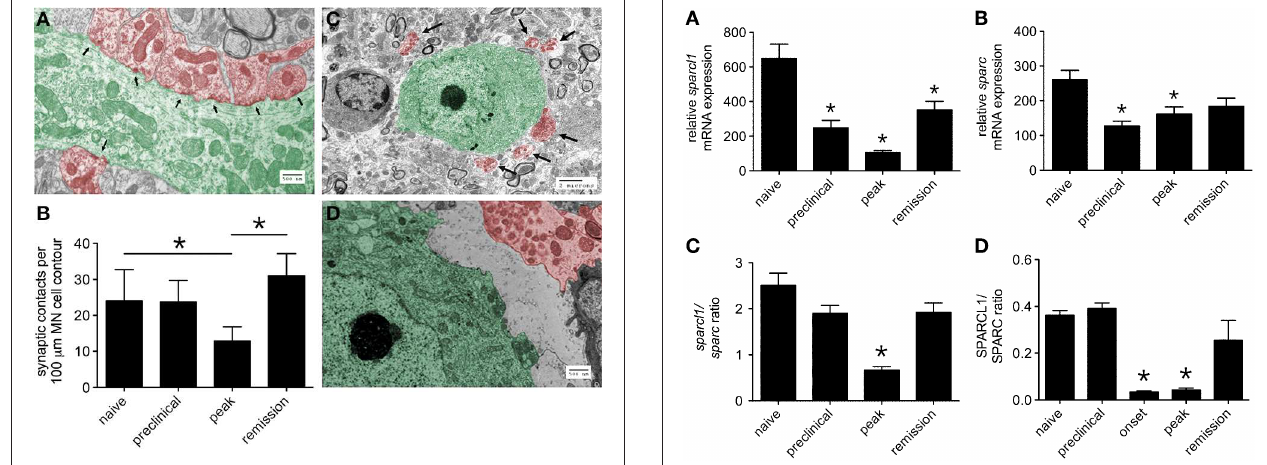
FIGURE 4 | Expression of both sparcl1 and sparc transcripts and SPARCL1 and SPARC proteins changes in lumbar spinal cord tissue over the course of relapsing EAE in SJL mice. (A) Relative sparcl1 mRNA expression fluxes over the course of relapsing EAE ( n = 5 mice per disease stage). (B) Relative sparc mRNA expression also changes over the course of relapsing EAE ( n = 5 mice per disease stage). (C) The calculated sparcl1 to sparc mRNA expression ratio shifts in favor of synapse inhibition at peak disease. (D) The same change in the SPARCL1 to SPARC